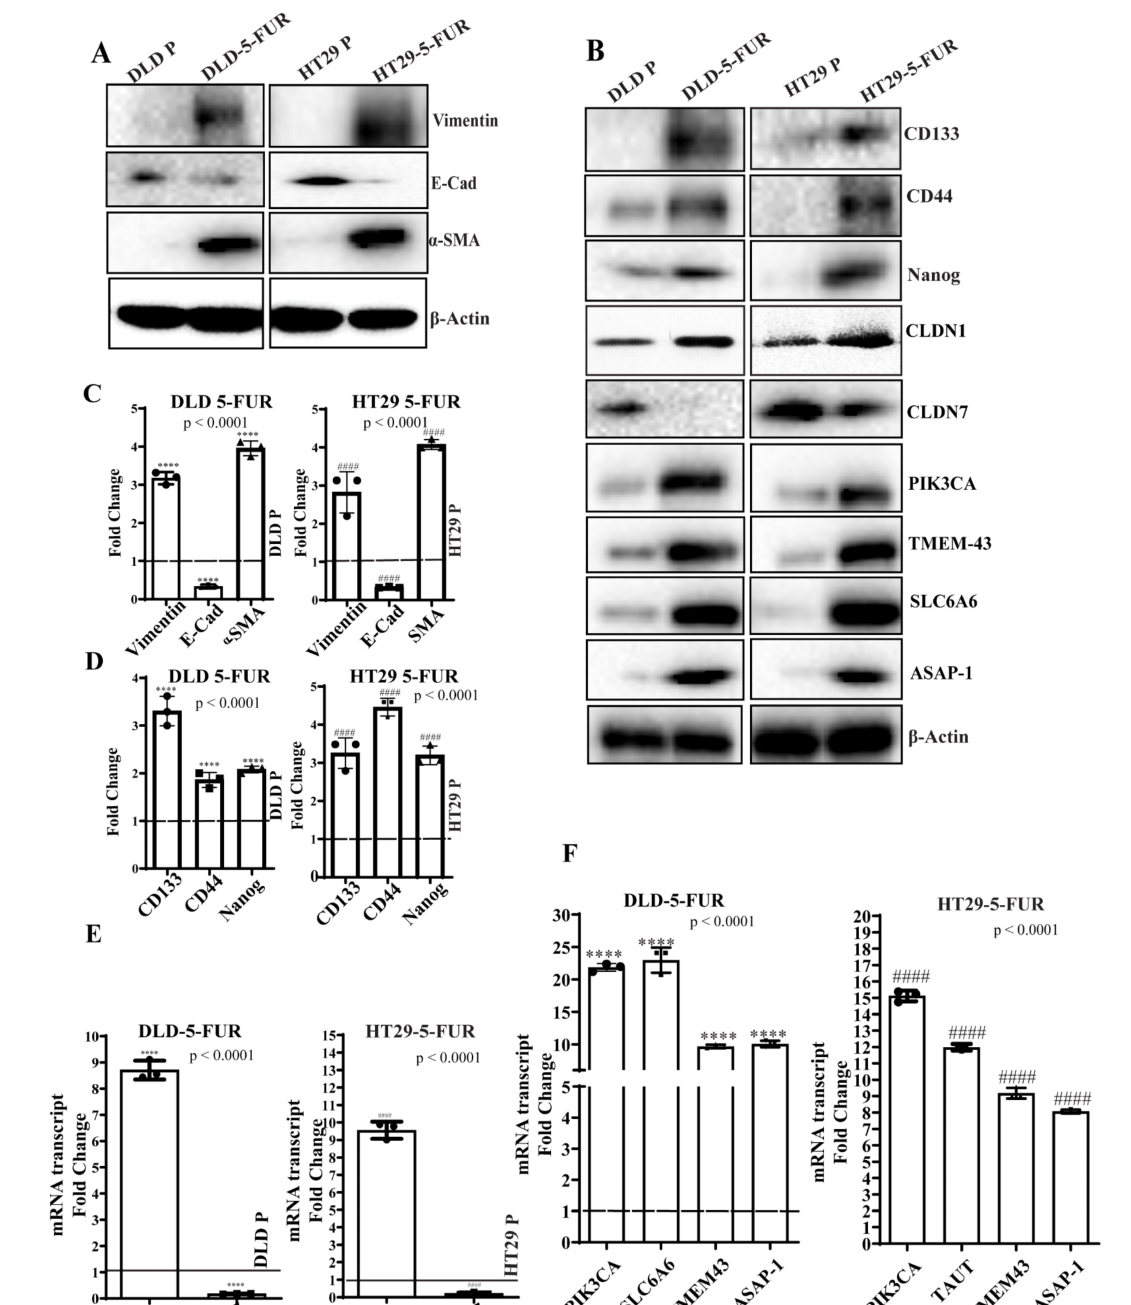
Figure 6. Expression status of markers for EMT and colorectal cancer stem cells along with signature proteins in chemore- sistant cells. ( A ) Western blotting analysis of EMT markers Vimentin, E-Cad, α -SMA in DLD and HT29 parental and 5-FUR cells ( B ) Western blot analysis of stem cell markers CD133, CD44, Nanog, CLDN1, CLDN7, PIK3CA, TMEM-43, SLC6A6, ASAP-1, and TMEM-43 in DLD and HT29 parental and 5-FUR cells ( C , D ) Densitometry of protein expression for EMT markers Vimentin, E-Cad, α -SMA and stem cell markers CD133, CD44, and Nanog in DLD and HT29 5-FUR cells as normalized against the reference protein β -Actin used as internal control. Y-axis represents fold change compared to DLD/HT29 parental cells. ( E ) mRNA transcript analysis of CLDN1 and 7 in DLD/HT29 parental and 5-FUR cells confirmed through qRT-PCR. ( F ) mRNA transcript analysis of PIK3CA, SLC6A6, ASAP-1 and TMEM-43 in DLD/HT29 parental and 5-FUR cells confirmed through qRT-PCR. Error bars presented are mean ± SD of three independent experiments ( n = 3). Statistical significance was determined by Student’s t-test and 1-way ANOVA with post hoc Tukey’s test for pairwise comparison. ****/ #### p ≤